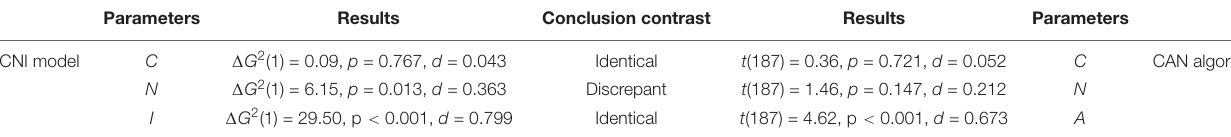
TABLE A4 | Test of differences in question-framing with the CNI model and CAN algorithm in Study 3b by Gawronski et al. (2017). Parameters Results Conclusion contrast Results